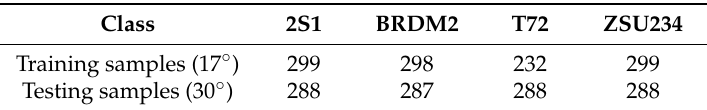
Figure 7. Optical images and SAR images of four different types of tanks at a depression angle of 30 ◦ . Table 6. Dataset of